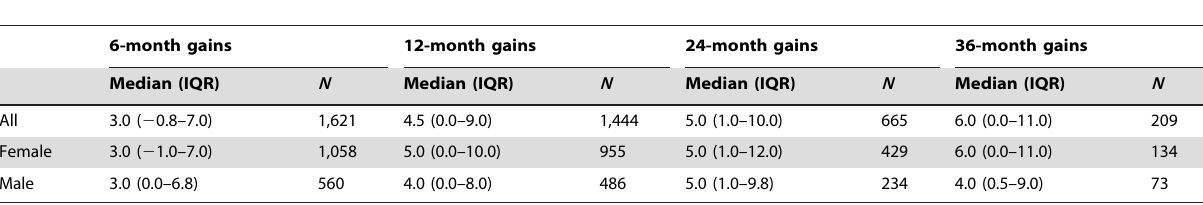
Table 3. Median weight gains (kilograms) during ART stratified by gender.